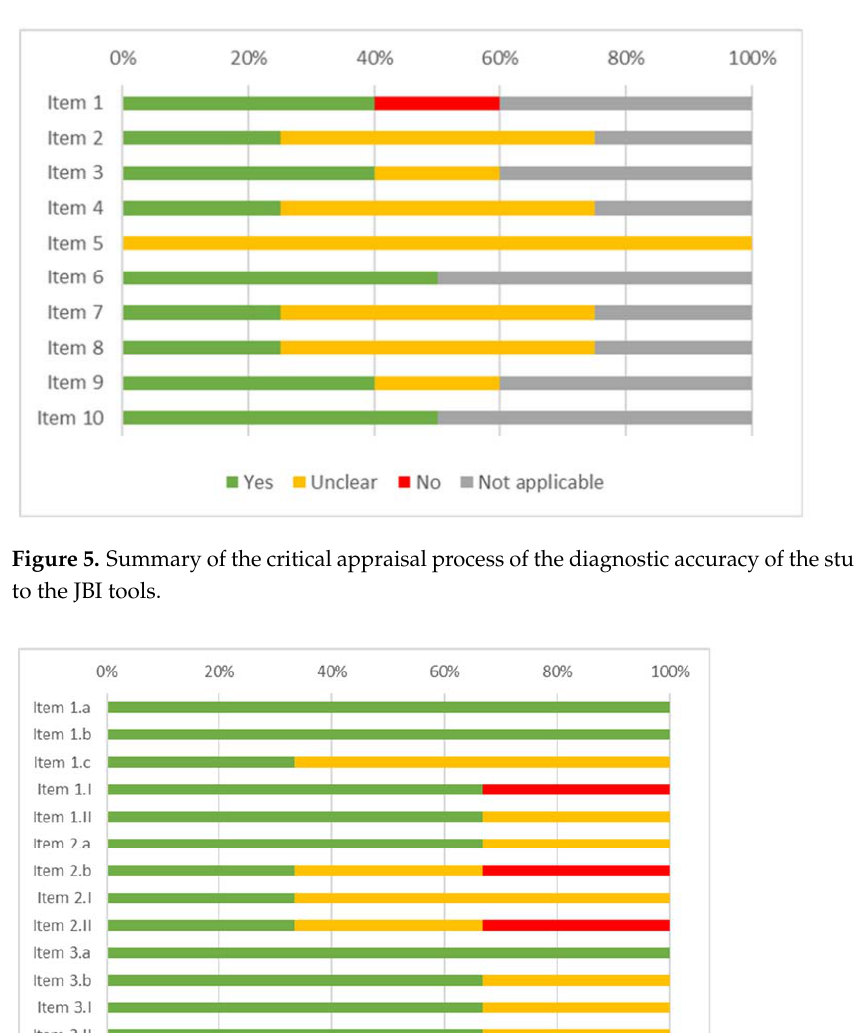
Figure 4. Summary of the critical appraisal process of the cohort studies according to the JBI tools Int. J. Environ. Res. Public Health 2022 , 19 , x [221a in Supplementary S3].